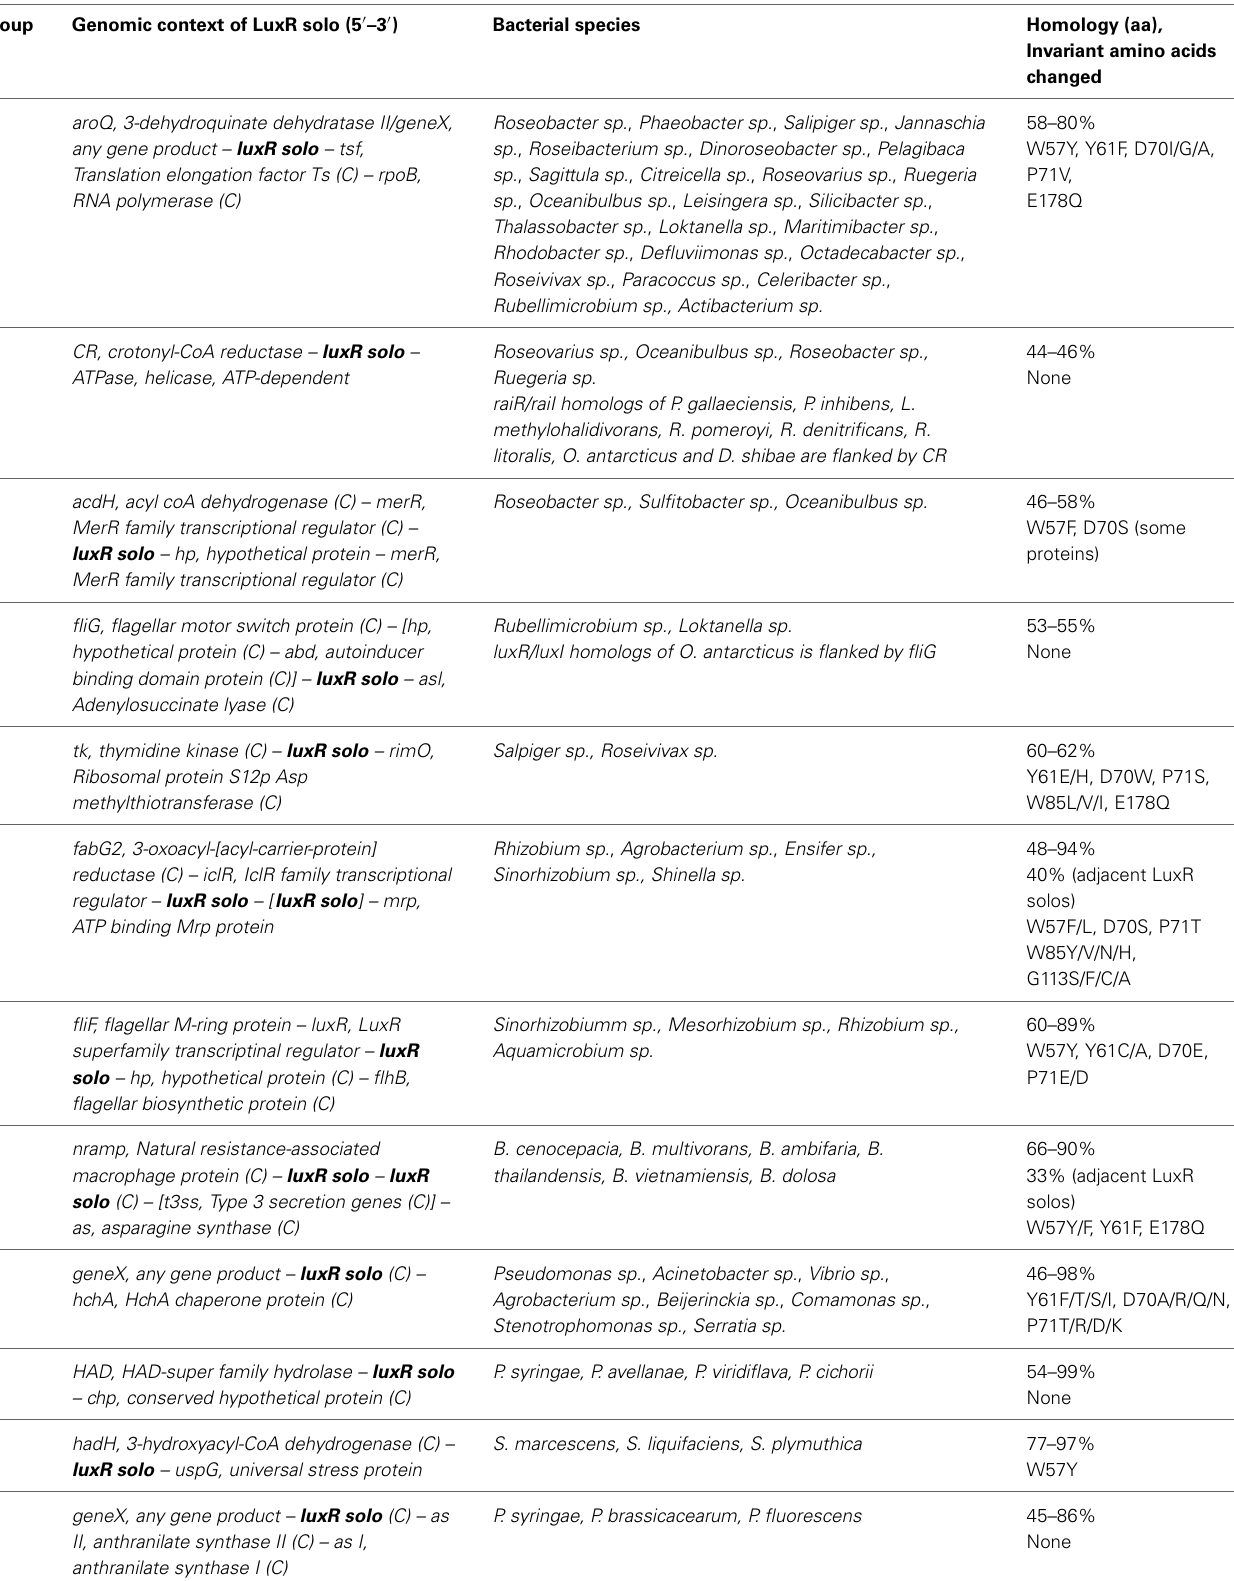
Table 4 | Groups of unknown LuxR